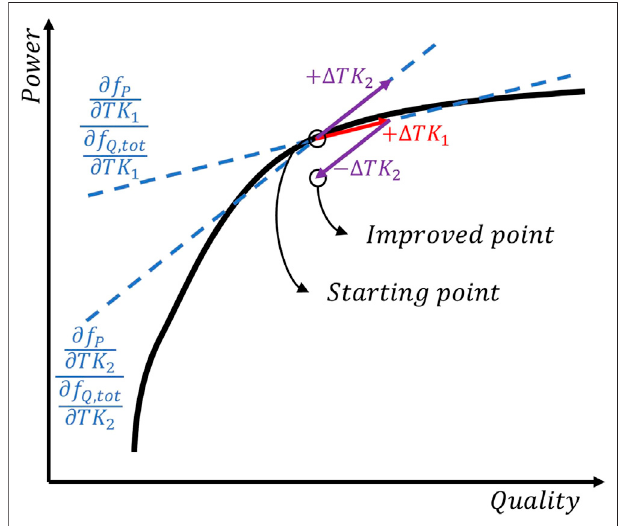
FIGURE 6 | When the ratio of the power and quality derivatives to the TKs are not equal, a better solution is